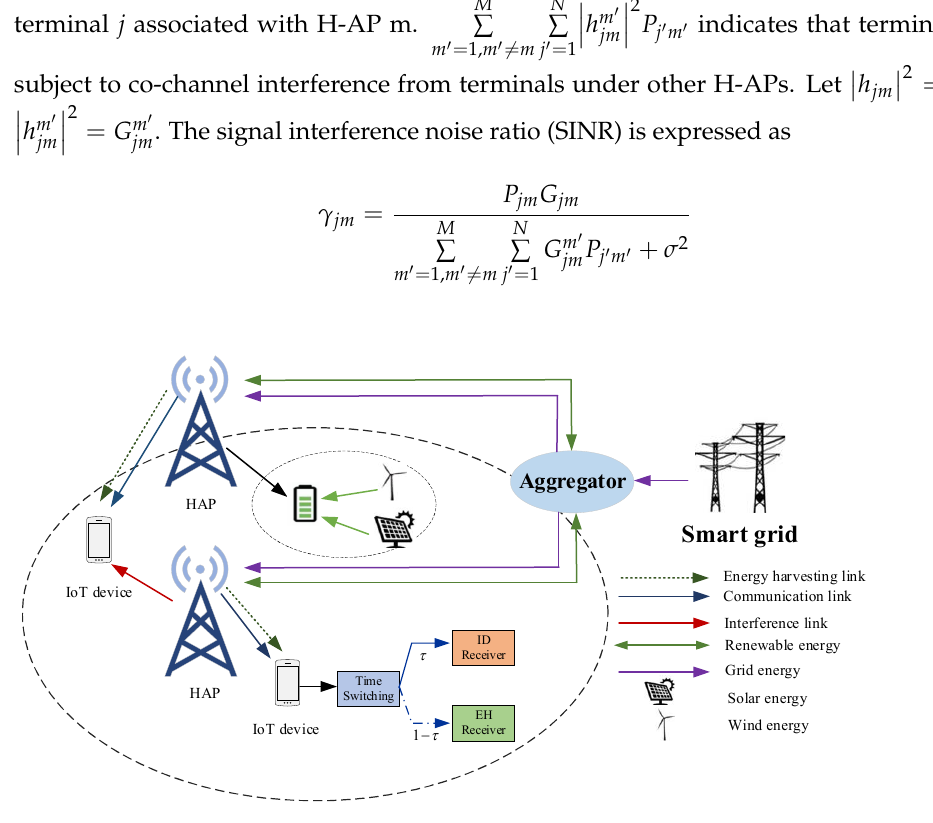
Figure 1. System model.